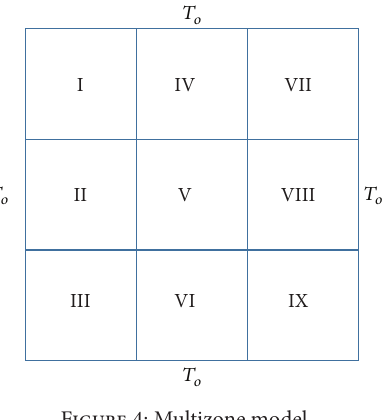
Figure 4: Multizone model.